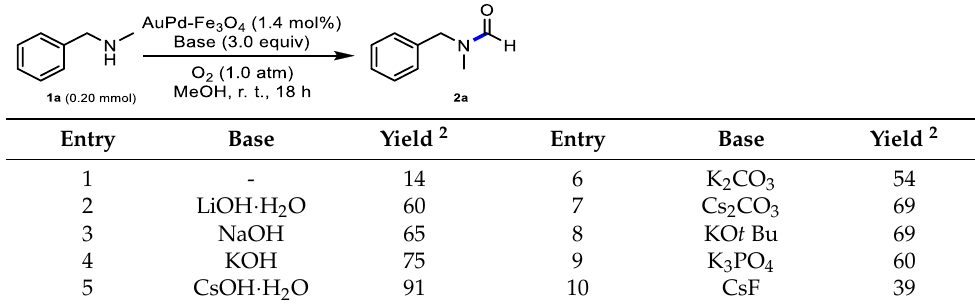
Table 2. Base screening of the N -formylation of amine 1 .